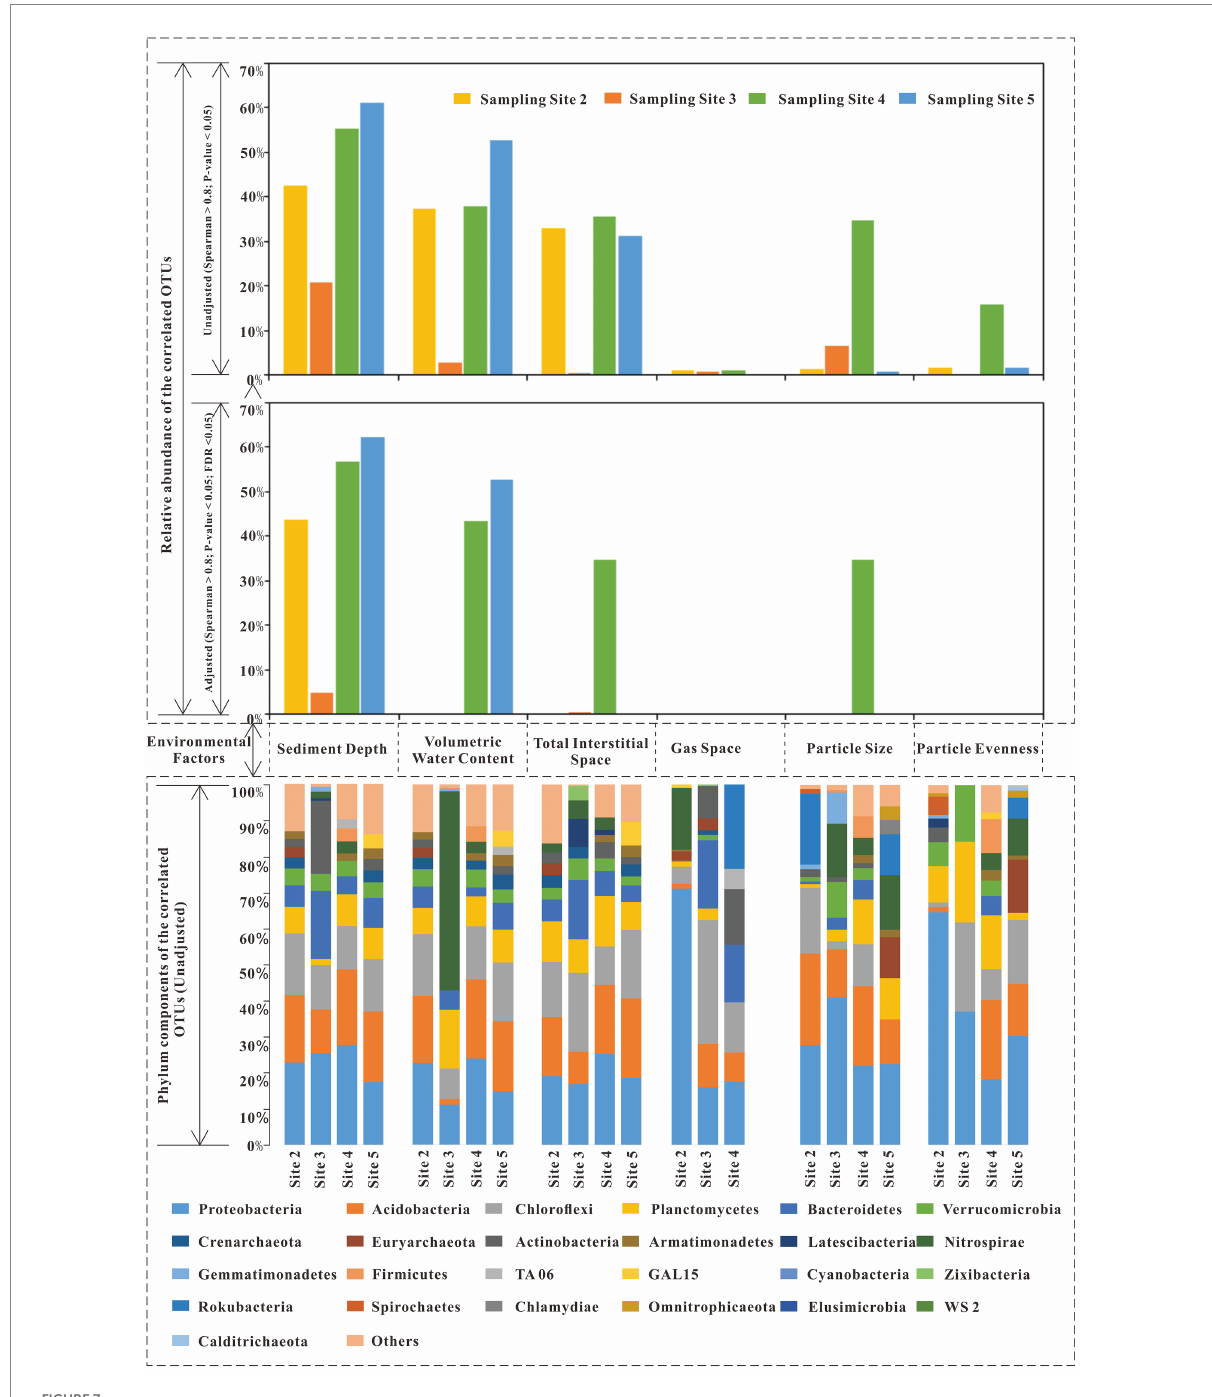
FIGURE 7 The correlated OTUs of six environmental factors (Spearman correlation coefficients larger than